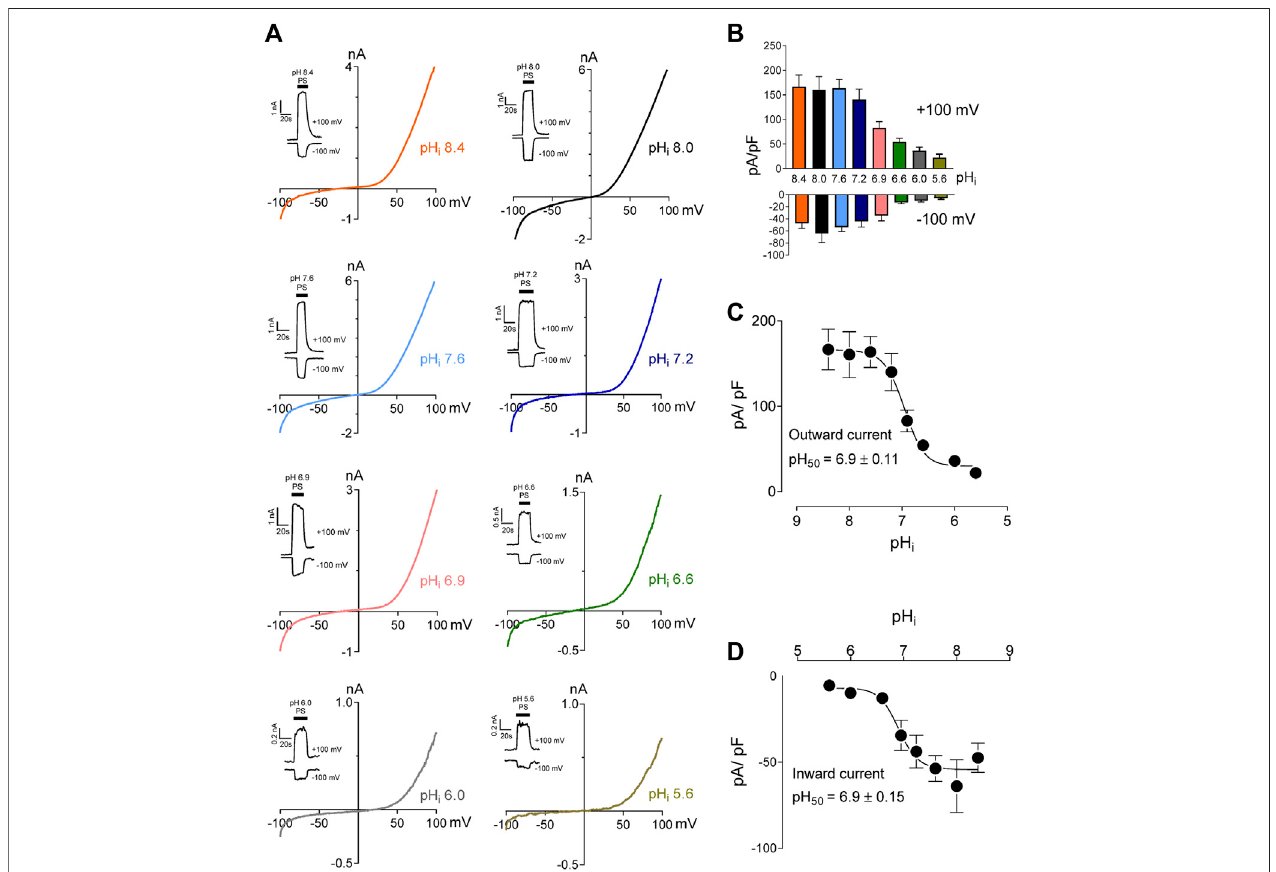
FIGURE2| Intracellularacidi fi cationblocksTRPM3activationbyPSinaconcentration-dependentmanner. (A) Representativerecordingsandtimecourses(insert) of TRPM3 current by ramp protocols ranging from − 100 to +100 mV at the indicated pH i . PS was applied through the extracellular solution (pH o 7.4) and different cells were exposed to different pH i while keeping that pH i constant. (B) Mean current amplitude of TRPM3 at the indicated pH i (mean ± SEM; n (cid:2) 8 – 14). (C,D) pH i concentration-dependence of TRPM3 activation by PS. c and d show outward and inward current, respectively, elicited by TRPM3 after extracellular PS application, by voltage ramp ranging − 100 to +100 mV. TRPM3 currents exerted at − 100 and +100 mV were considered as inward and outward currents, respectively, and wereutilizedfortheseplots.Allcurrentswerenormalized tothecorrespondingcapacitance ofthecelloverexpressinghTRPM3-GFP. Eachdatapointisthemeanof 8 – 14 cells with the error bar showing SEM, at the indicated pH i . Inhibitory pH 50 values were measured separately for outward (pH 50 (cid:2) 6.9 ± 0.11) and inward (pH 50 (cid:2) 6.9 ± 0.15)